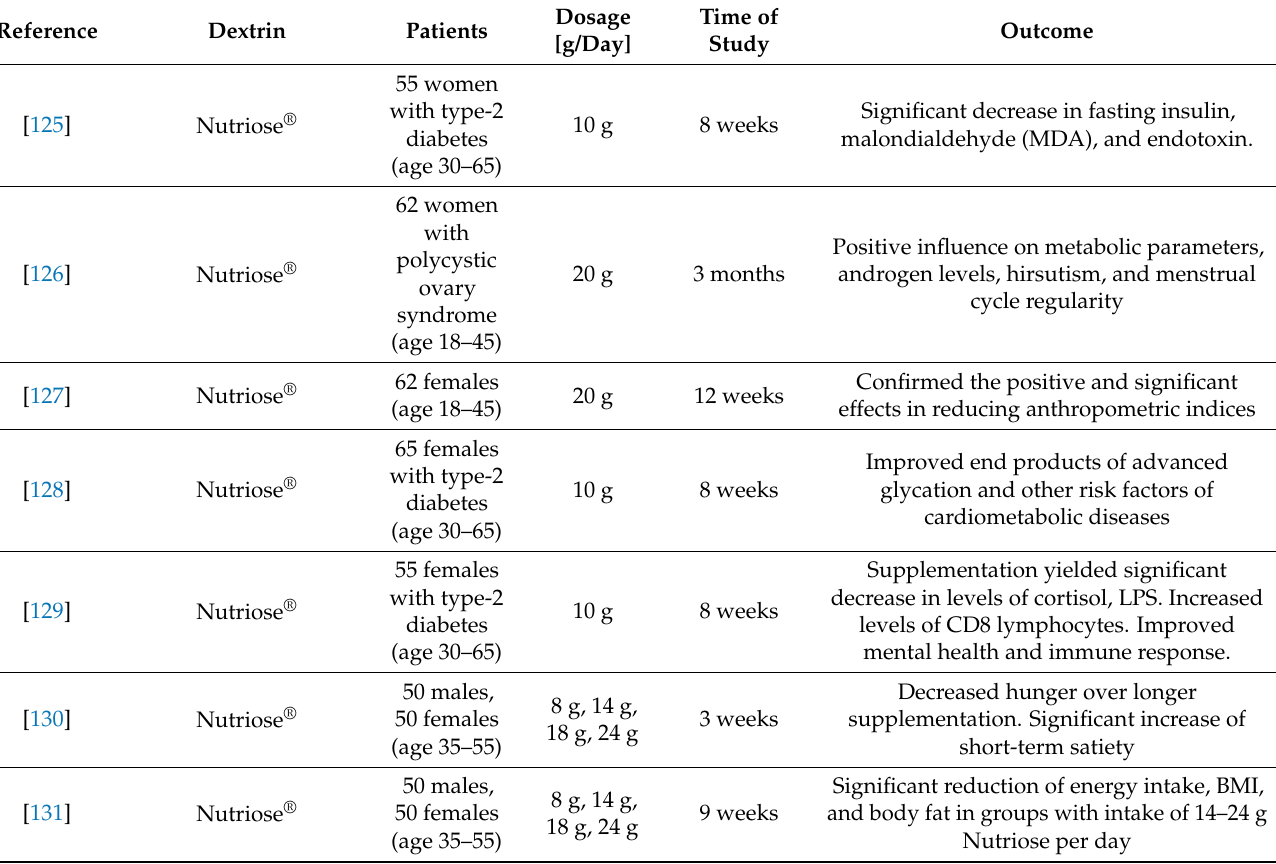
Table 3. Clinical trials on the effect of resistant dextrins on various health